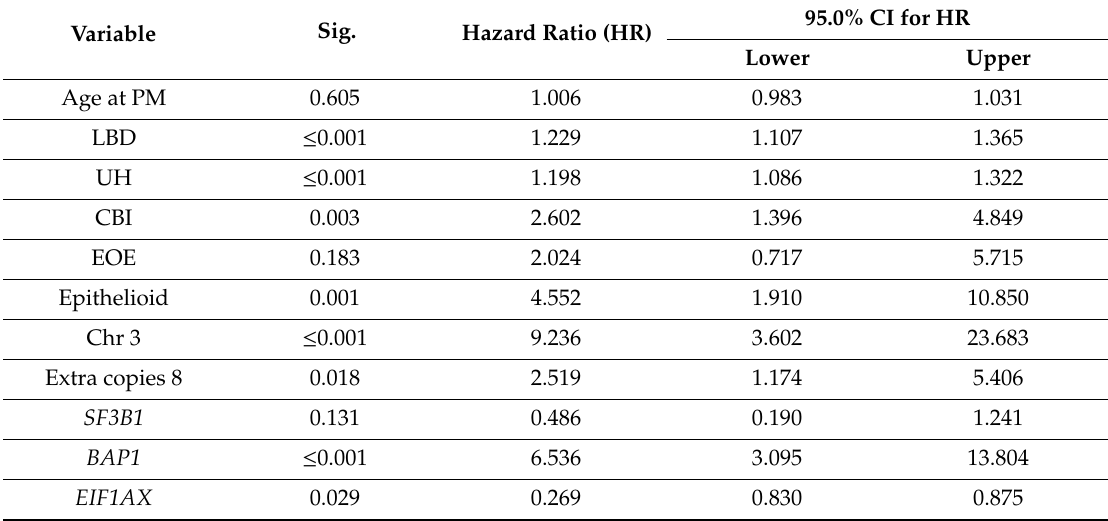
Table 2. Univariate analysis of n = 117 UM patients treated at Liverpool Ocular Oncology Centre. Variable